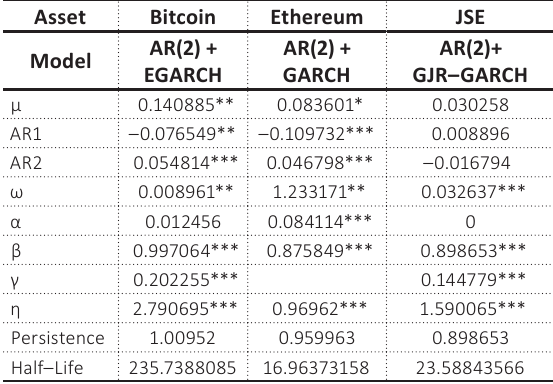
Table 4. Parameter estimates for the selected models